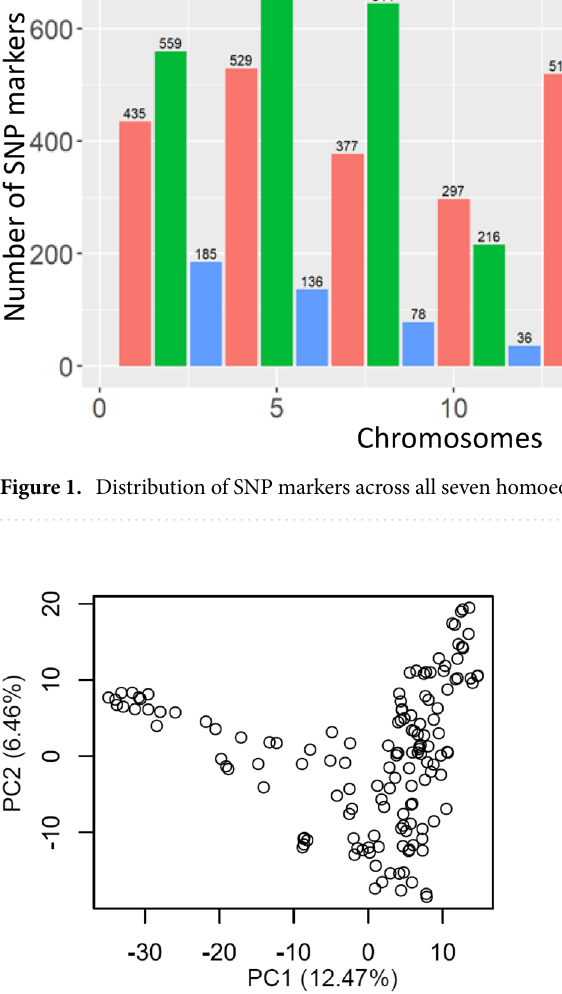
Figure 2. Principle component analysis (PCA), showing the distribution of genotypes along with two components, obtained using 7,491 polymorphic SNP markers and 143 wheat